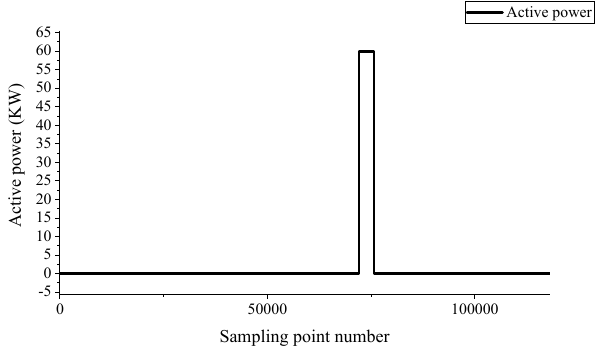
Figure 9. Added load EV11 power time curve.